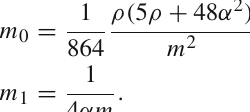
In terms of rho the binding energy becomes